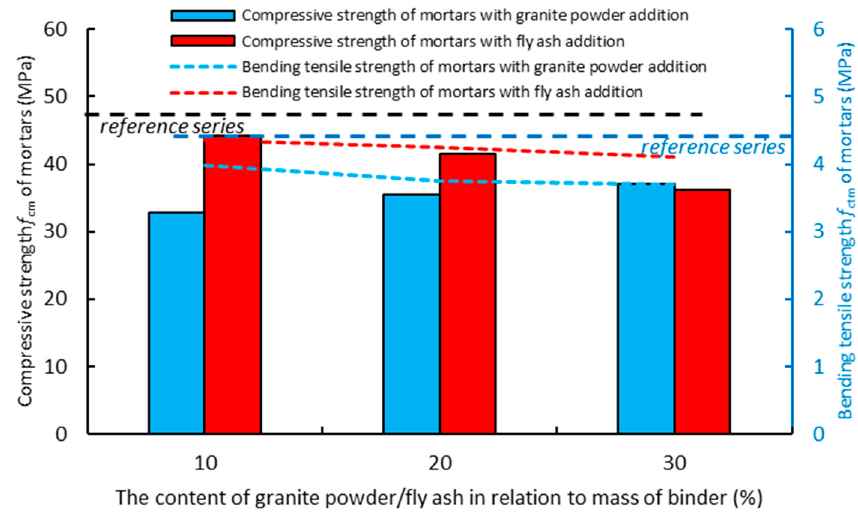
Figure 11. The effect of replacing the cement with the granite powder or fly ash on the compressive strength ( f cm ) and bending tensile strength ( f ctm ) of the air-cured hardened after 28 cementitious composites after 28 days.